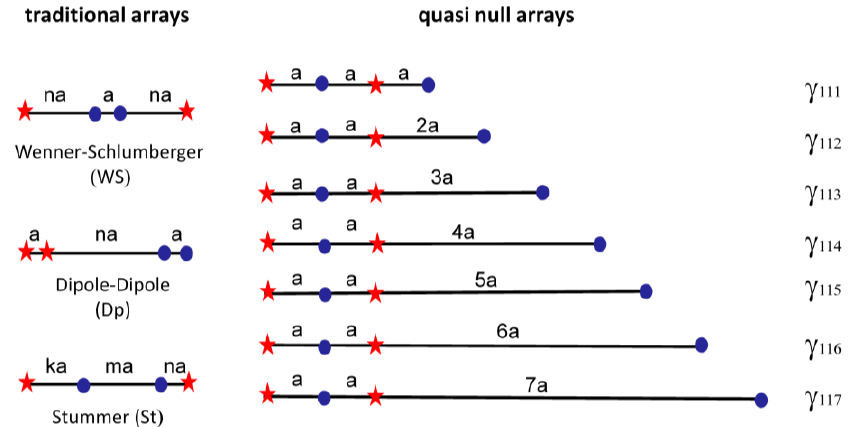
Figure 4. Traditional and quasi-null arrays, stars denote current-, circles indicate potential electrodes, n is a properly chosen integer. For the parameters of the Stummer array, see [27].